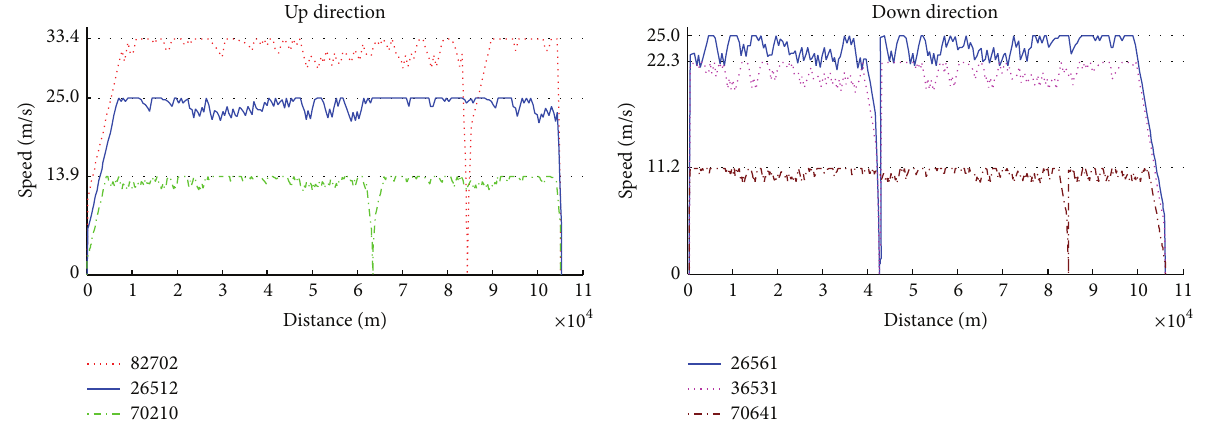
Figure 18: Train speed-distance curve (NCBS: blocking sections 2 ∼ 5 in the left).